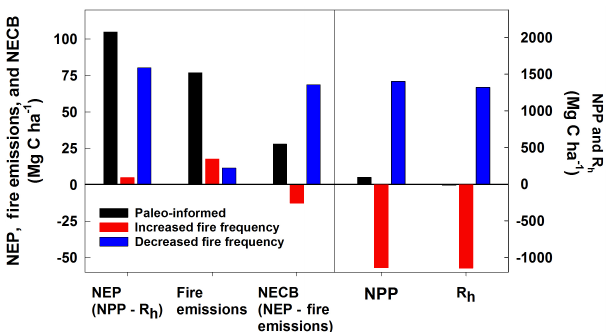
Figure 3. Accumulated anomalies in fluxes relative to the equilib- rium scenario, in MgCha − 1 , summed over the entire 4561-year simulation period. NEP, fire emissions, and NECB (left y axis) and NPP and R h (right y axis) for the paleo-informed (black), in- creased fire frequency (red; 155-year mean FRI), and decreased fire frequency (blue; 90-year mean FRI) scenarios. Negative (positive) numbers indicate a decrease (increase) in total carbon flux com- pared to the equilibrium scenario.